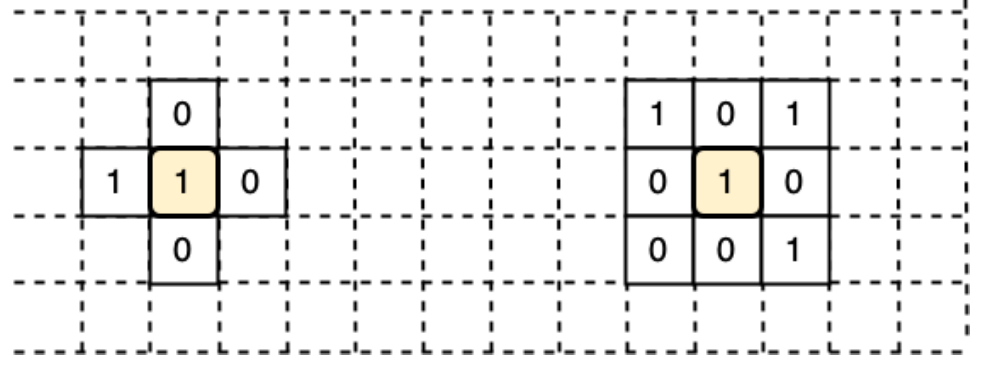
Figure 4. ( Left ): von Neuman neighborhood; ( Right ): Moore